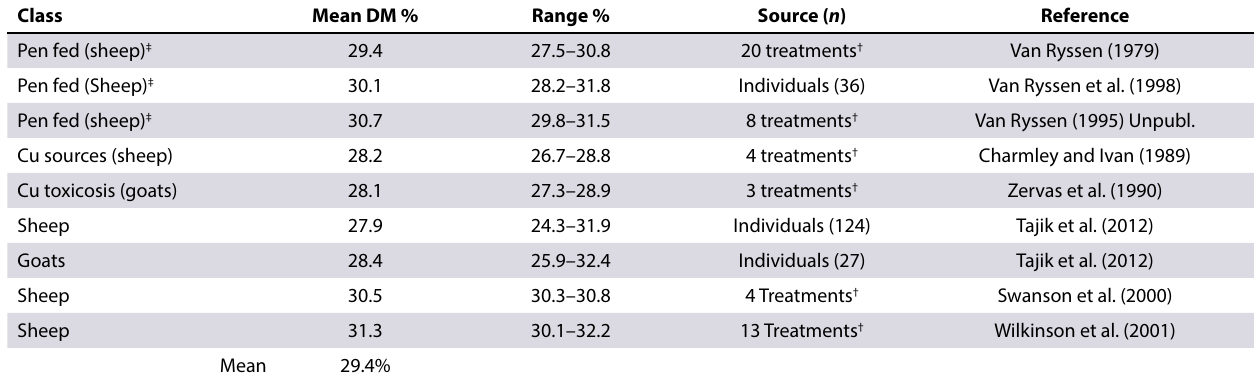
Table II: Percentage dry matter (DM) in the livers of sheep and goats, as reported in the